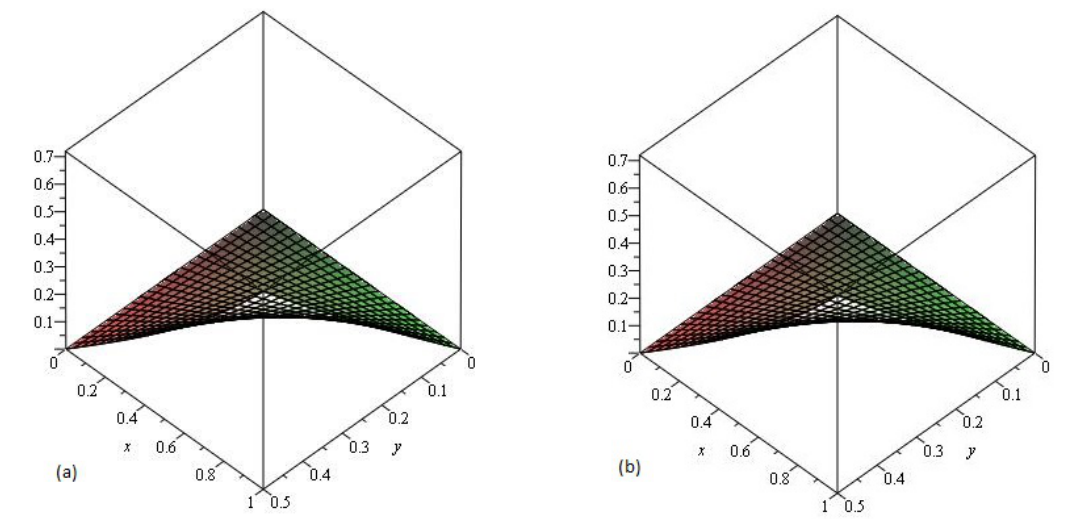
Figure 11. The ( a ) Exact and ( b ) LADM solutions of υ ( x , y , z , t ) of Example 4.5, at γ = 1.